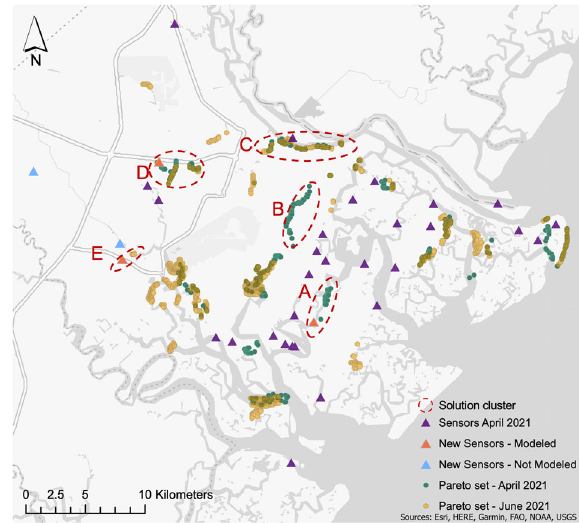
Fig. 3 Set of non-dominated solutions resulting from the multi-objective optimization process. Non-dominated solutions give a prioritized set of new sensor locations, and clusters of solutions among the full non- dominated solution set are highlighted.